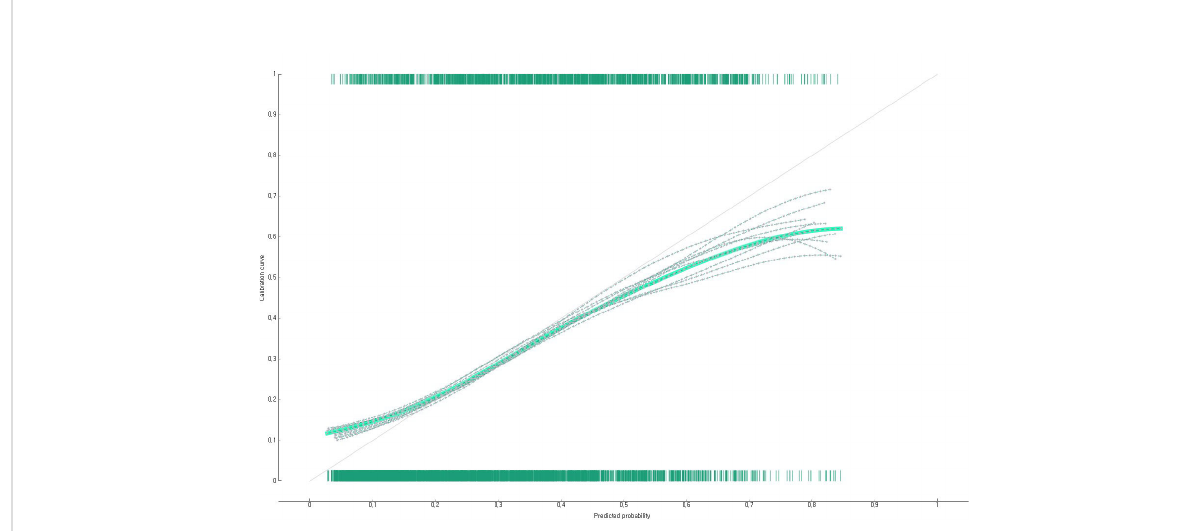
FIGURE 5 Calibration plot of the nomogram for predicting impaired fasting glucose in South Korean